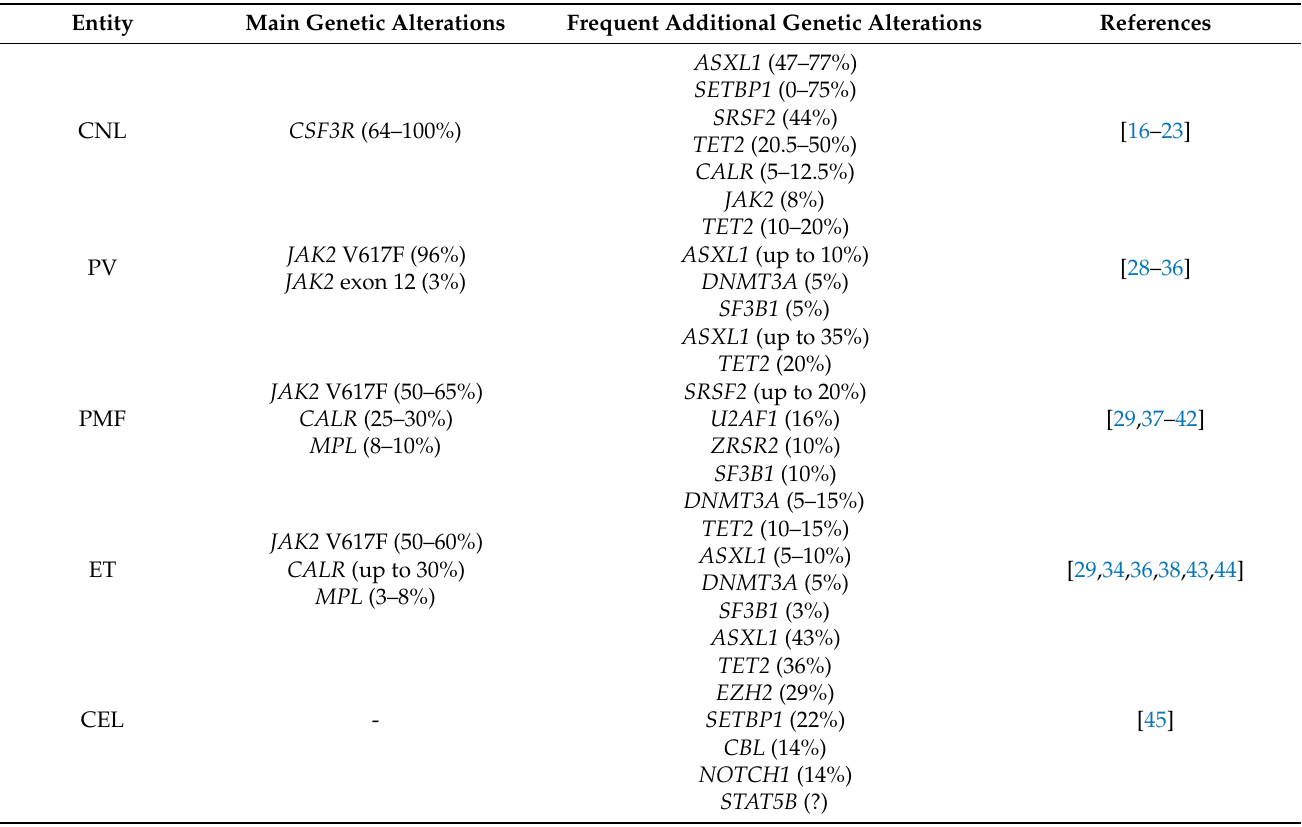
Table 1. Main genetic alterations in myeloproliferative